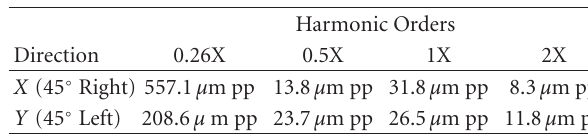
Table 1: Amplitude of the most important harmonic orders of the vibrations measured at the generator bearing no. 1 during an instability